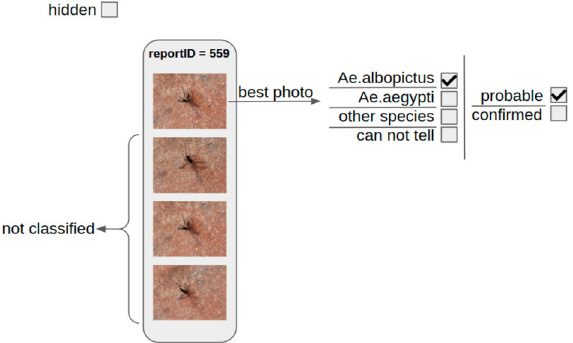
Figure 2. Schematic figure of the labeling process. Participants usually upload several images in a single report. The best photo is picked by the validator who first marks the harassing or non-appropriate photos as hidden. All the non-best photos are marked as not classified. In some rare events, two or three images are annotated from the same report. The mosquito images are classified into four different categories ( Aedes albopictus , Aedes aegypti , other species or can not tell) and also the confidence of the label is marked as probable or confirmed. In this paper we excluded the not classified, the hidden and the can not tell images.